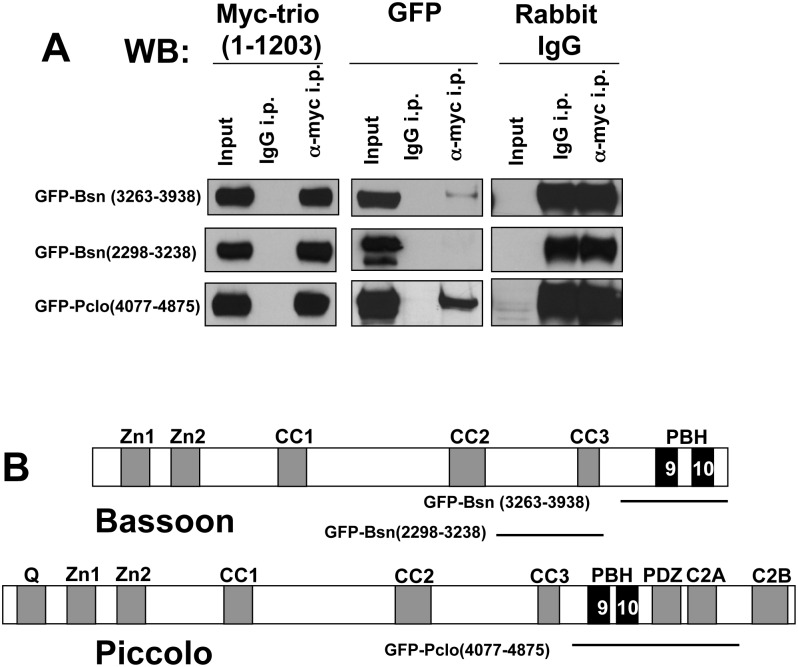
Trio interacts with the PBH9/10 regions in Piccolo and Bassoon.(A) Western blots evaluating co-IP of GFP-Bassoon (Bsn) and Piccolo (Pclo) polypeptides with Myc-Trio1-1203 (using Myc antibody) from COS7 cell lysates. IP and Westerns were performed as in Fig 5B. (B) Schematic of Bassoon (top) and Piccolo (bottom) illustrating the following domains: Zinc finger (Zn), coiled-coil (CC), Piccolo/Bassoon homology (PHB; only 2 of the 10 PHB domains depicted), poly-Q (Q) PDZ, and C2 domains. Below the domain diagram are single lines depicting the regions of Bassoon and Piccolo that bound to Trio in panel A. The PBH 9 and PBH 10 domains are the only conserved domains in this region of these proteins.